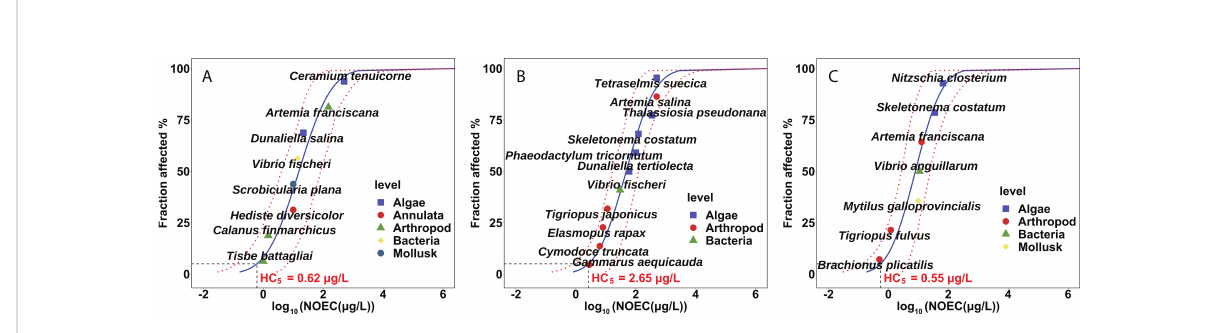
FIGURE 3 Marine species sensitivity distribution of (A) Ag + , (B) Zn 2+ , and (C) Cu 2+